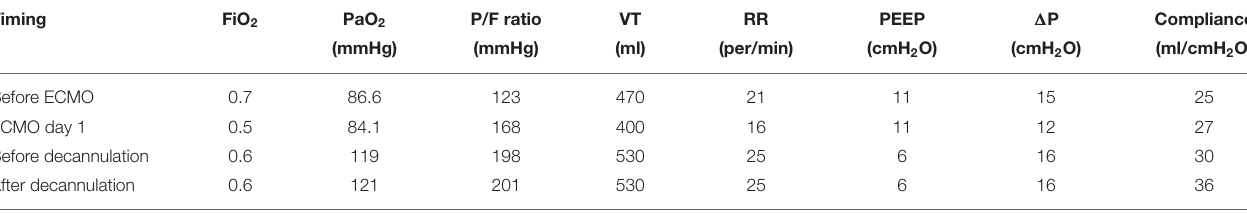
TABLE 2 | Ventilation parameters and respiratory mechanics during